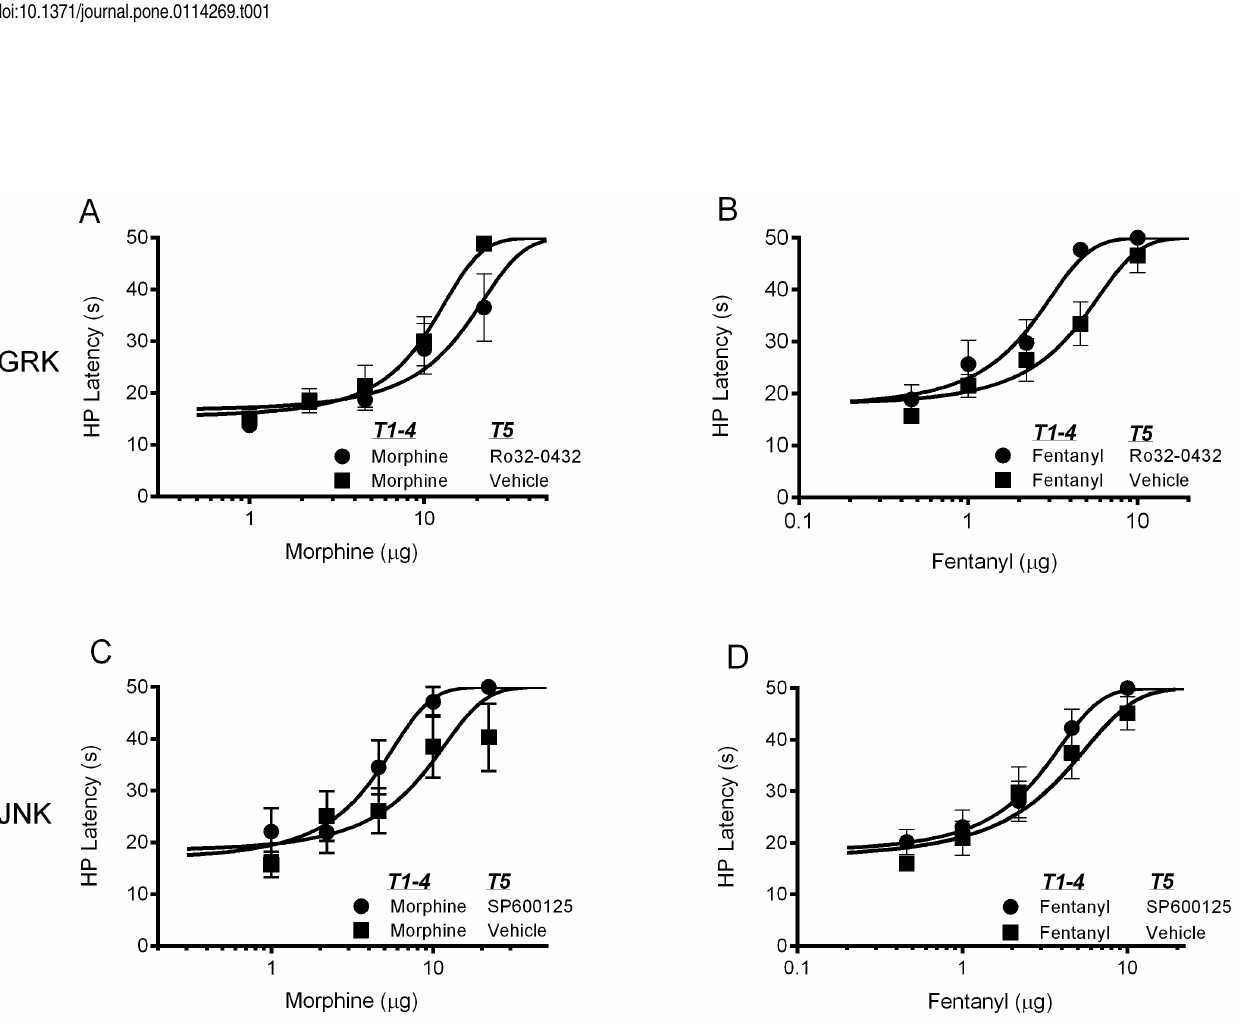
Fig. 5. GRK/PKC contributes to the expression of fentanyl tolerance, and JNK contributes to the expression of morphine tolerance. A) Microinjection of the GRK/PKC inhibitor Ro 32-0432 (400 ng/0.4 m l) into the ventrolateral PAG 20 min prior to administration of cumulative doses of morphine on Trial 5 enhanced the expression of morphine tolerance (F(1,71) 5 5.061, p 5 .0276). B) In contrast, microinjection of Ro 32-0432 on Trial 5 reversed the expression of fentanyl tolerance (F(1,76) 5 10.55, p 5 .0017). C) Microinjection of the JNK inhibitor SP600125 (100 ng/0.4 m L) on Trial 5 reversed the expression of morphine tolerance (F(1,76) 5 4.436, p 5 .0385), but D) had no effect on the expression of fentanyl tolerance (F(1,81) 5 0.880, p 5